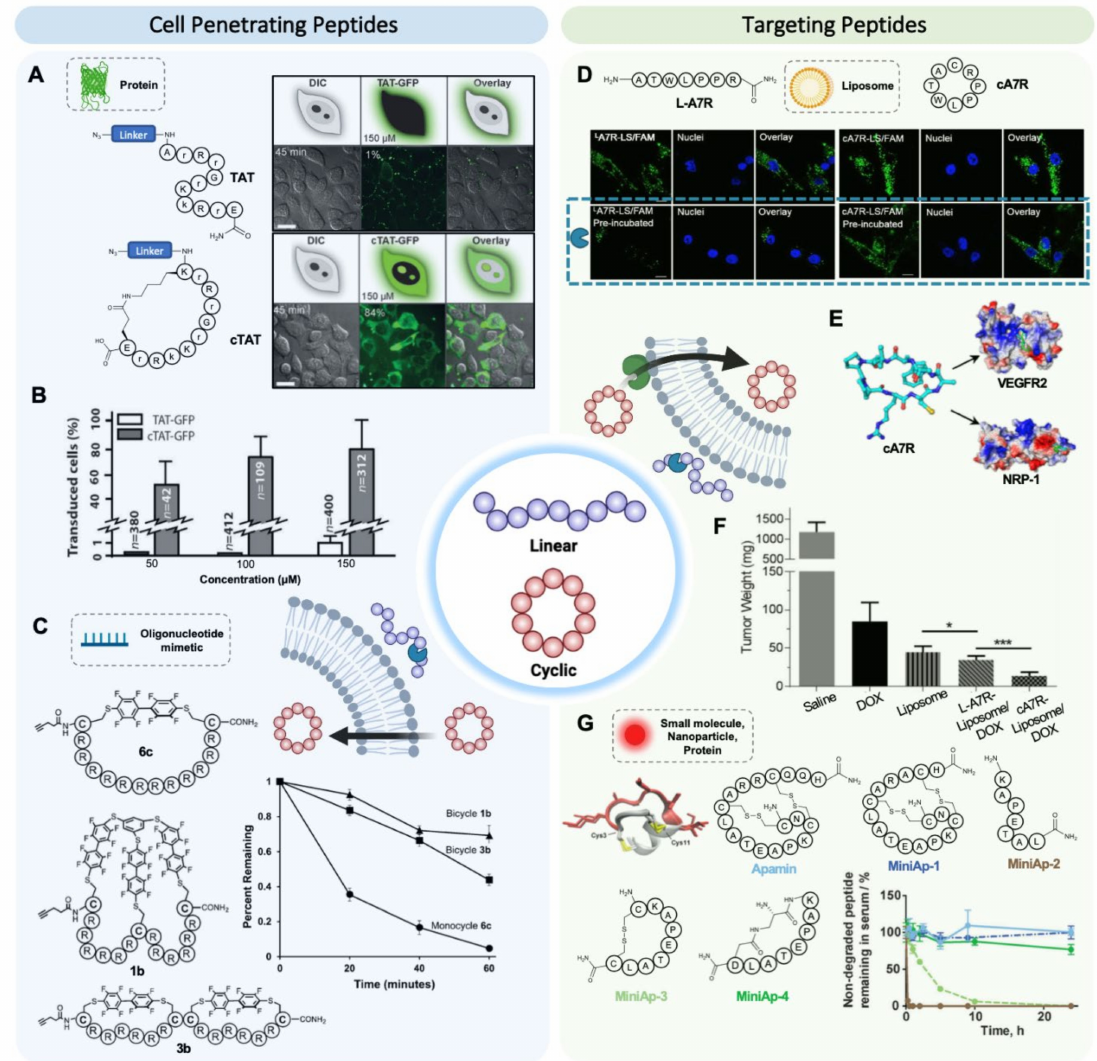
Figure 3. Cyclization of peptides enhances proteolytic stability and thus improves cell penetration or targeting. ( A ) Chemos- elective conjugation via azide–alkyne cycloaddition of GFP to cTAT enhances transduction of living cells. Confocal microscopy images (scale bar = 15 µ m) show efficient transduction of 84% of HeLa cells with the cTAT–GFP conjugate, compared with the 1% achieved by TAT–GFP, adapted with permission from [44], John Wiley & Sons, 2014. ( B ) Quantifica- tion of the percentage of transduced cells for 50, 100, and 150 µ M of TAT–GFP and cTAT–GFP [44]. ( C ) Bicyclic peptides demonstrate enhanced proteolytic stability relative to monocyclic peptides after incubation with trypsin at 37 ◦ C for up to 1 h, adapted with permission from [46], John Wiley & Sons, 2018. ( D ) Cyclic A7R-conjugated liposomes (LS) retain binding capacity to U87 cells after pre-incubation with 50% mouse serum for 4 h, while binding of L-A7R-LS is dramatically reduced, adapted with permission from [50], Elsevier, 2015. ( E ) 3D model of cA7R and its binding mode on VEGFR2 and NRP-1 receptors, as simulated by molecular docking [50]. ( F ) cA7R-conjugated LS loaded with doxorubicin (DOX) shows a very significant reduction in U87-derived xenograft weight in nude mice, confirming the positive influence of the cyclic structure on therapeutic efficacy [50]. ( G ) 3D representation of MiniAp-4. Proteolytic stability of the BBB shuttle apamin and its four derivatives MiniAp1–4 after incubation with 90% human serum at 37 ◦ C for 24 h, adapted with permission from [52], John Wiley & Sons,